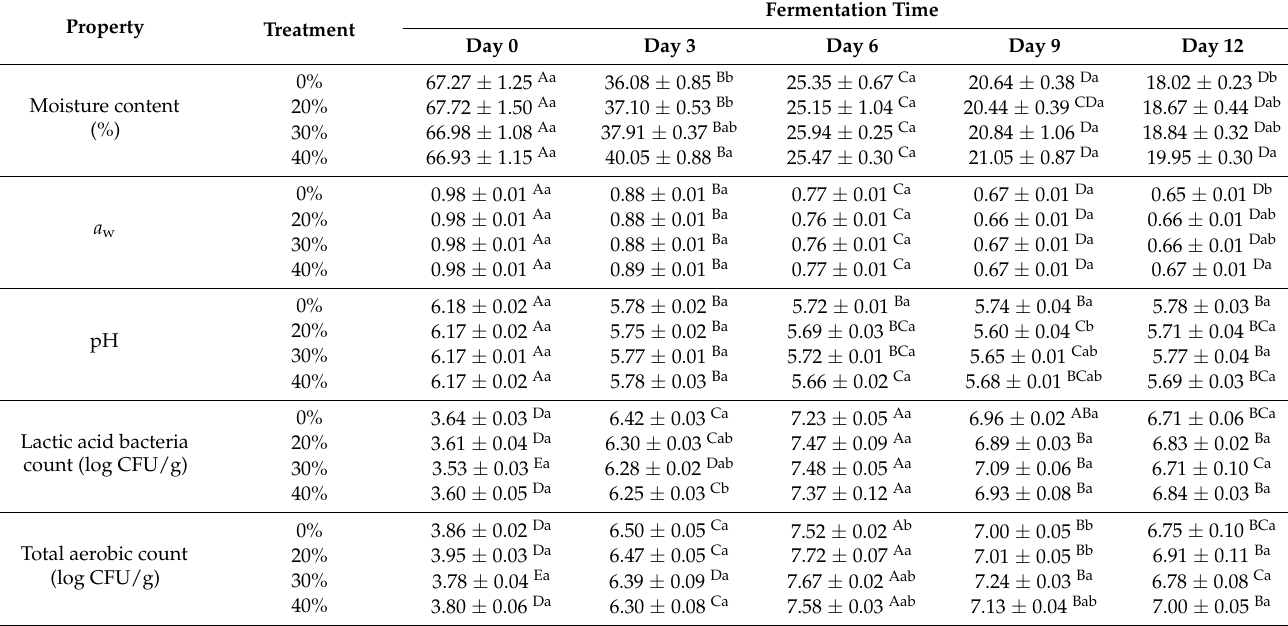
Table 1. Physical and microbial changes in traditional dry sausage with different KCl substitution ratios during